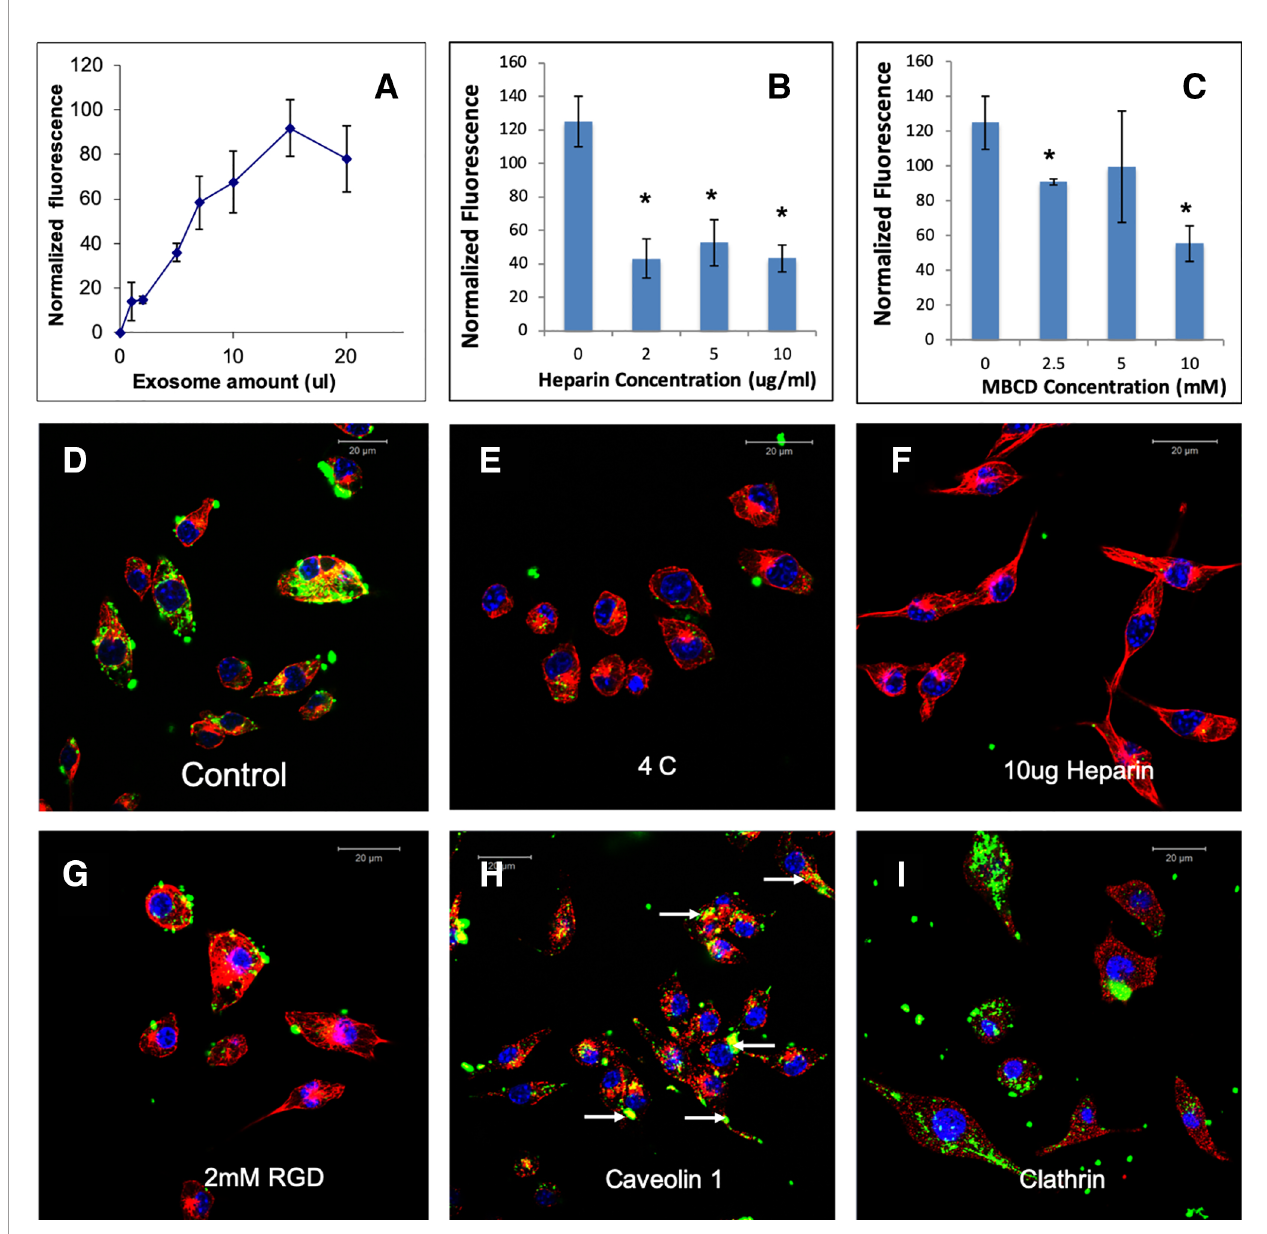
FIGURE 4 | Endocytosis of HMSC extracellular vesicles (EVs) by J774A.1 monocytes: (A) Graphical representation of dose-dependent and saturable endocytosis of fl uorescently labeled human mesenchymal stem cell (HMSC) EV by J774A.1 cells. Data points represent mean fl uorescence (n=6) +/ − SD. The EV volume was standardized as described under the methods section. (B) Graph showing the dose dependent inhibition of HMSC EV endocytosis after pre-treatment of the EVs with heparin to block interaction with the cell surface heparan sulfate proteoglycans (HSPGs). Data represent mean percentage fl uorescence with respect to control +/ − SD. (C) Graph showing the reduction in HMSC endocytosis after disruption of target cell membrane cholesterol with varying doses of methyl- b -cyclodextrin (MBCD). Data is presented as mean percentage fl uorescence with respect to control +/ − SD. Representative confocal micrograph depicting the endocytosed fl uorescently labeled HMSC EVs within target HMSCs after 1 h of incubation at 37°C. (E) Representative confocal micrograph indicating the abrogation of HMSC EV endocytosis when the experiment is performed at 4°C. (F) Representative confocal micrograph showing that pre-treatment of EVs with heparin blocks HMSC EV endocytosis. (G) Representative confocal micrograph of HMSC EV endocytosis after pre-treatment of the cells with 2 mM RGD peptide to block cell surface integrins. In images (D – G) , green fl uorescence represents endocytosed EVs. Red fl uorescence represents tubulin counter stain and blue fl uorescence indicates 4 ′ ,6- diamidino-2-phenylindole (DAPI) nuclear stain. (H) Confocal micrograph showing colocalization of endocytosed HMSC EVs (green) with caveolin1 (red). (I) Confocal micrograph showing the absence of co-localization between endocytosed EVs (green) and clathrin (red). * represents statistical signi fi cance (P < 0.05, ANOVA followed by Tukey ’ s ad-hoc ) with respect to